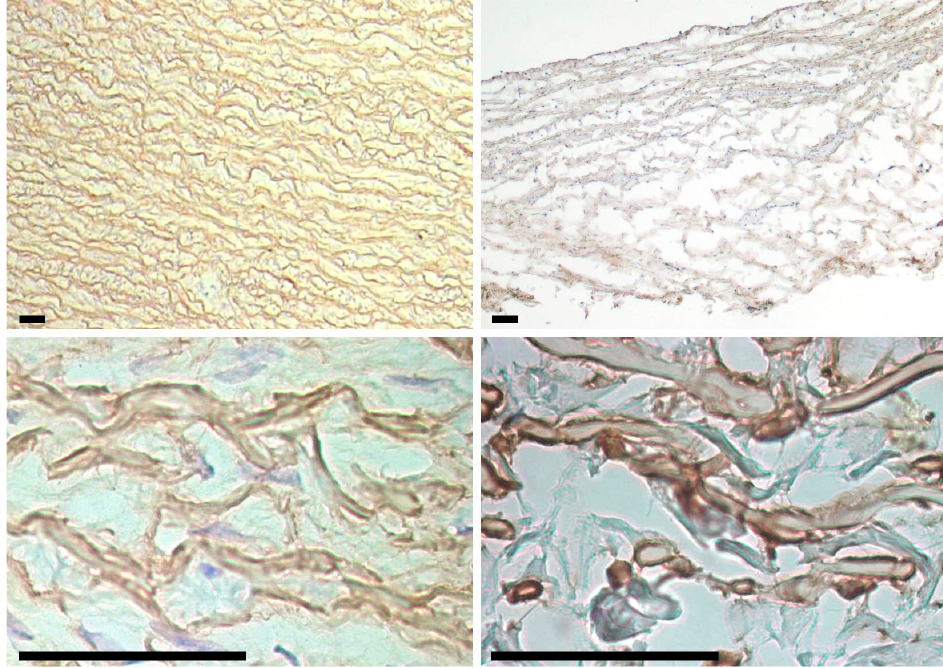
Figure 8. Fibrillin in porcine aortic ( left column ) and bovine jugular vein ( right column ) walls. Fibrillin is found in elastin fibers throughout the entire wall thickness ( top row ) and envelops the fibers outside ( bottom row ). Scale bars are 50 µm.